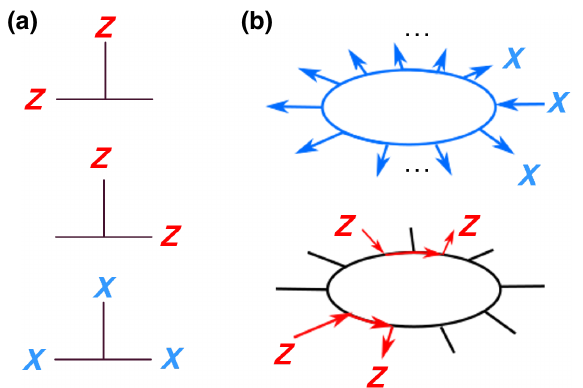
FIG. 18. (a) Tensors that correspond to a two-qubit repetition code or a three-qubit stabilizer state stabilized by the generators shown. (b) By gluing the horizontal legs of these tensors, one can create larger tensors with more legs whose stabilizers can be determined through operator pushing.